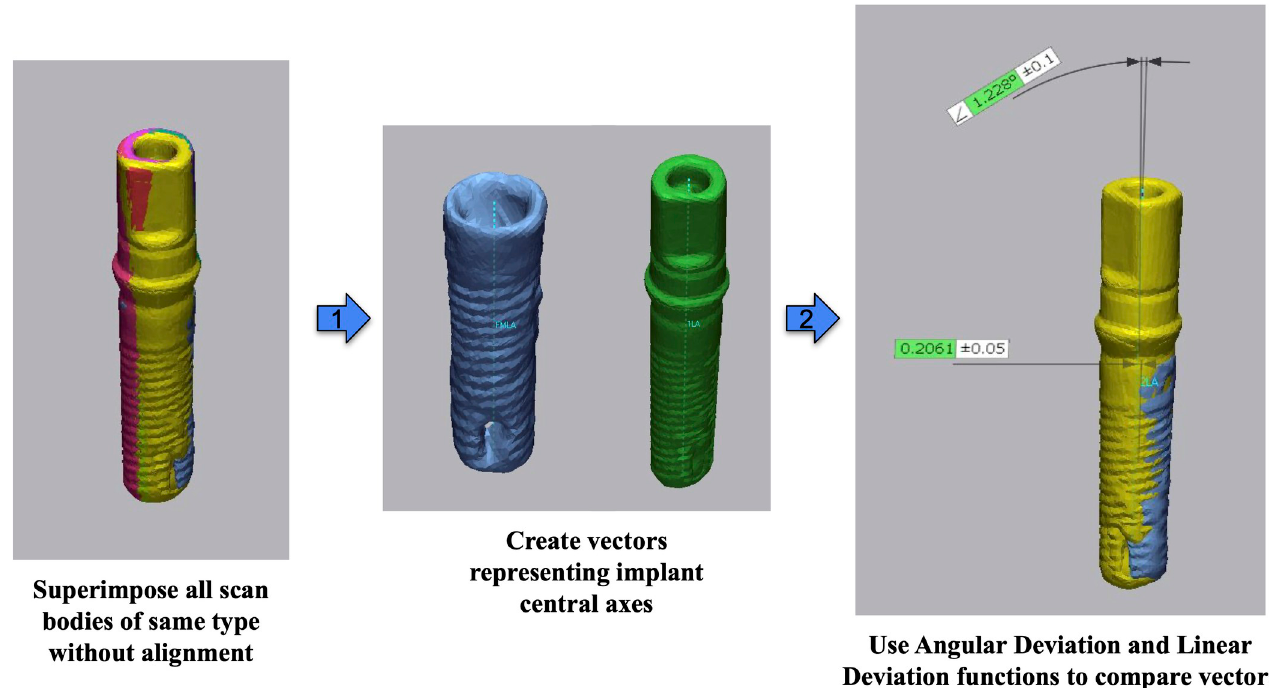
Fig 5. Superimposition of the scan bodies and